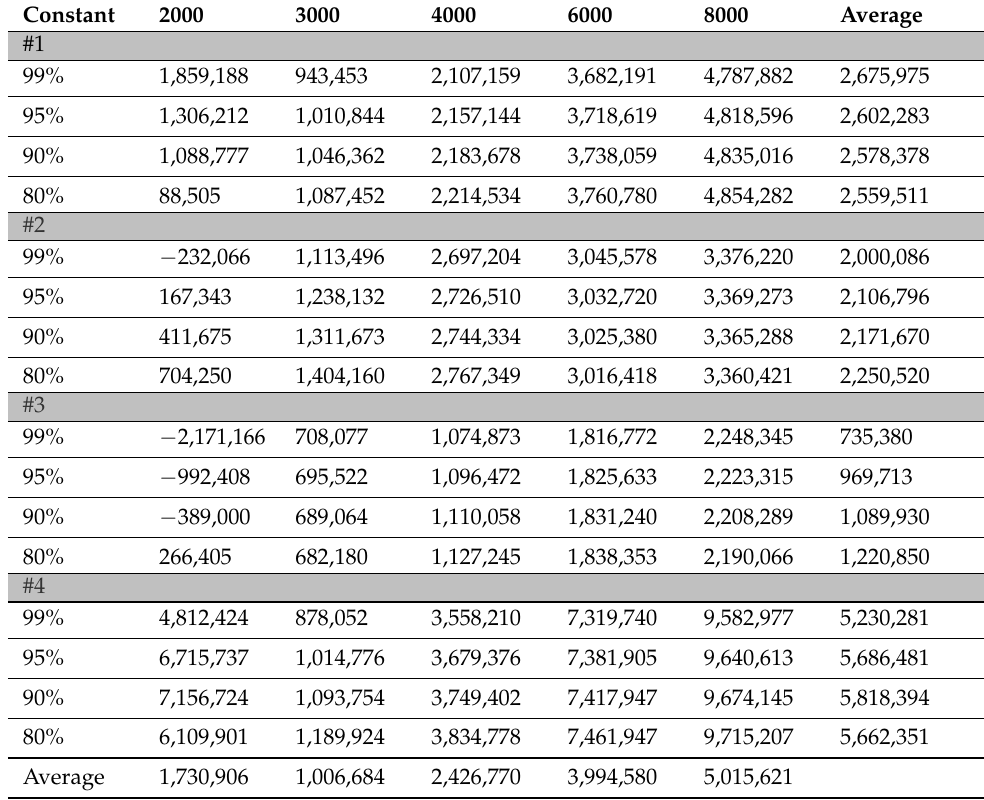
Table 5. Cost savings based on constant values in each confidence interval (unit: